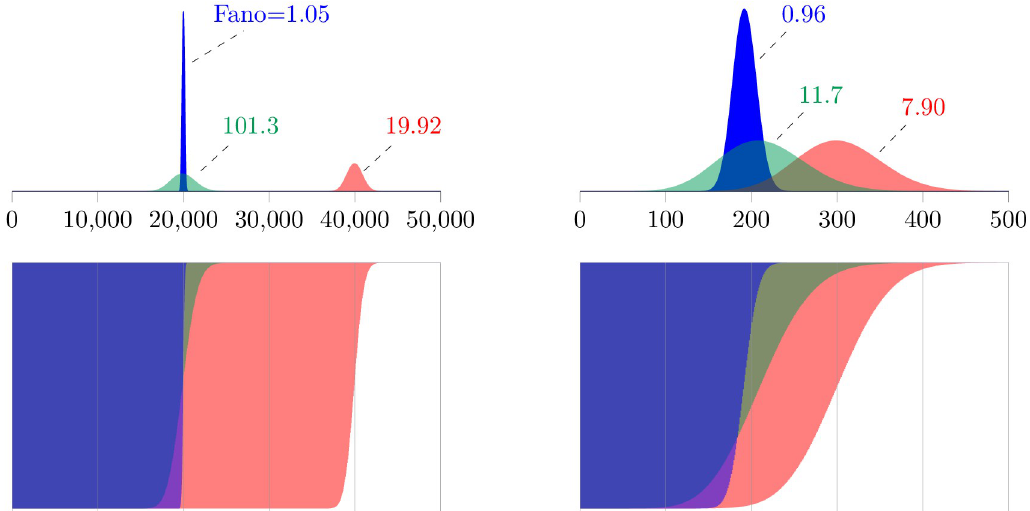
Fig 4. Gametic TE load calculated using the master equation model. Top: Stationary population distributions of TE load in haploid genomes calculated using the evolutionarily neutral master equation model, Eqs (20)–(22). For mean loads similar to Mimulus (left) and Drosophila (right), no overdispersion is observed in simulations absent copy-and-paste transposition ( η = 0, Fano ½ n � � 1 ). Green and red histograms show overdispersed population distributions of TE load that are obtained when copy- and-paste transposition is included. Mimulus parameters: ν = 0.1, m = 10 9 ; η 0 , η = 2000, 0 (blue), 200, 0.095 (red), 20, 0.099 (green). Drosophila parameters: ν = 0.1, m = 5000; η 0 , η = 20, 0 (blue), 1, 0.1 (green), 2, 0.1 (red). See Sec 6 of S1 Text for numerical